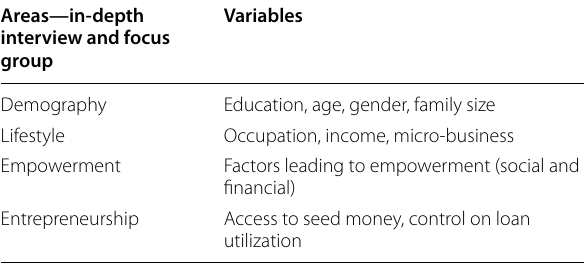
Table 1 Themes and variables of the study Areas—in‑depth interview and focus